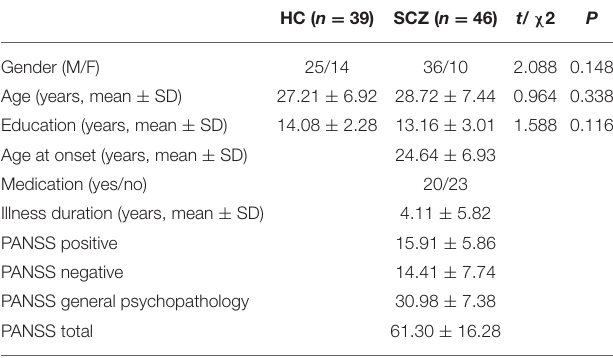
TABLE 1 | Demographic and clinical characteristics of all the participants.